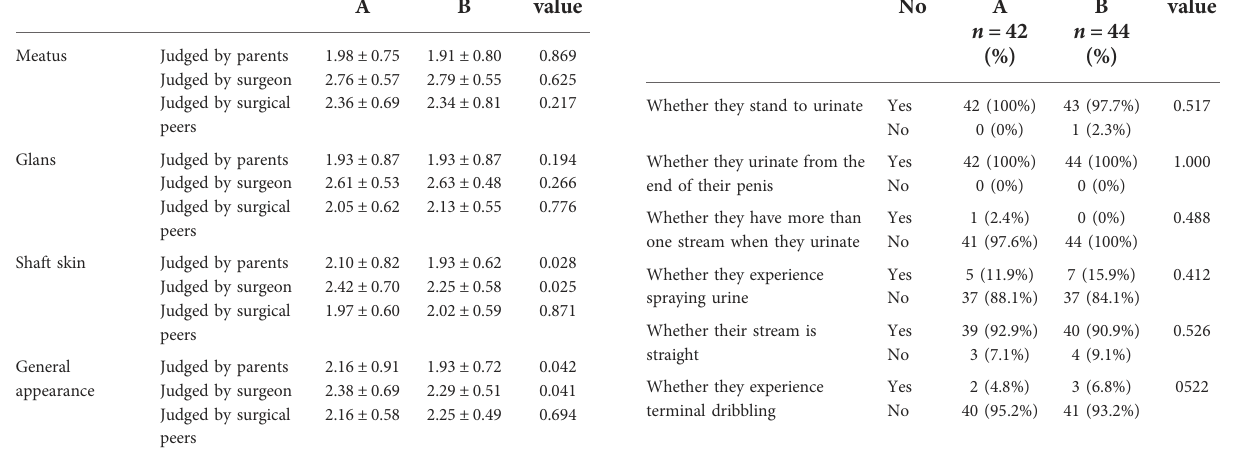
TABLE 3 Comparison of the two groups on PPPS, as judged by parents, the surgeon, and surgical peers 3 months after surgery. PPPS item